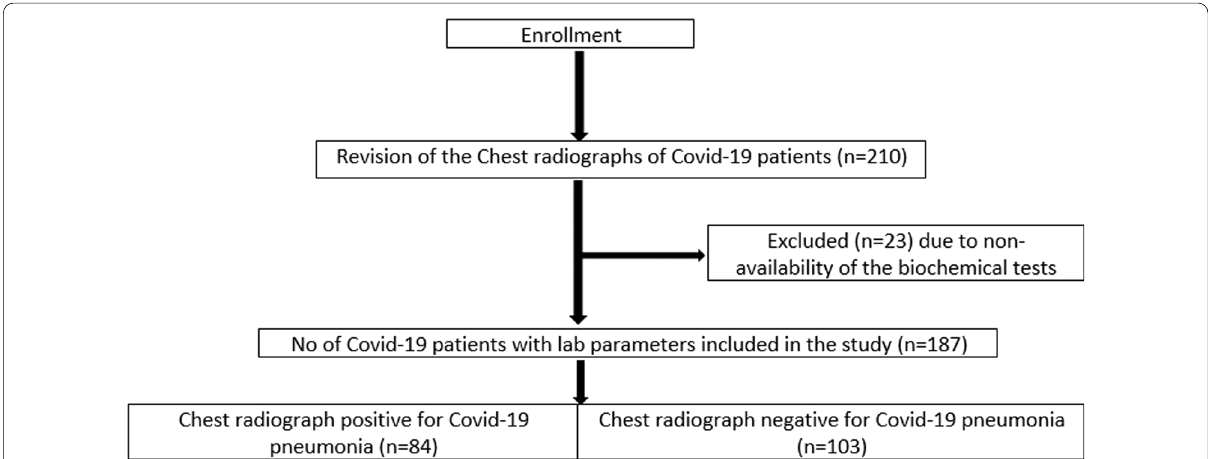
Fig. 1 Schematic diagram of study information flow analysis. The initial chest radiographs of 187 patients were analyzed and divided into two parts ( N 84 and N 103) depending upon the evidence of pneumonia = =